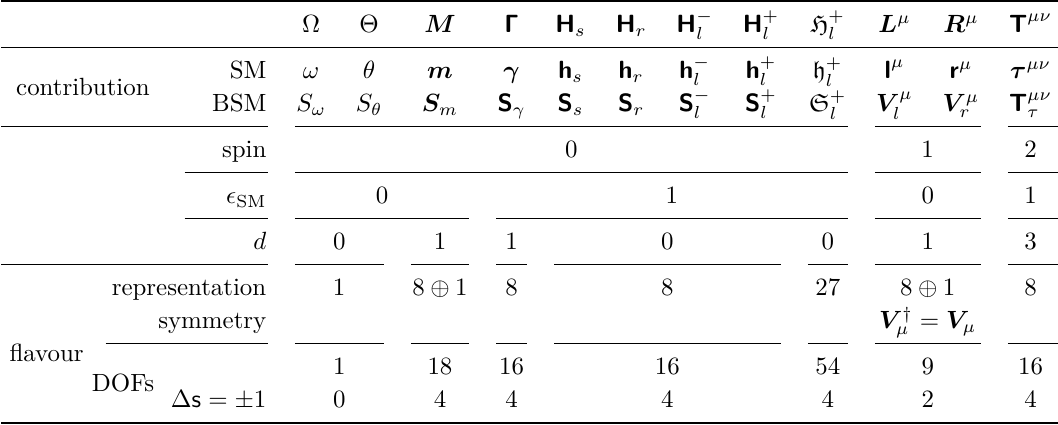
Table 6. List of all external currents interacting with QCD at the strong scale including both SM and BSM contributions. The first three rows list their spin, the order in (cid:15) contribute and their mass dimension d . Rows four, five, and six list their representations and symmetries under flavour rotations as well as the resulting DOFs. The last row counts the number of strangeness violating DOFs, which are the only relevant DOFs for currents starting contribute at order (cid:15) . SM